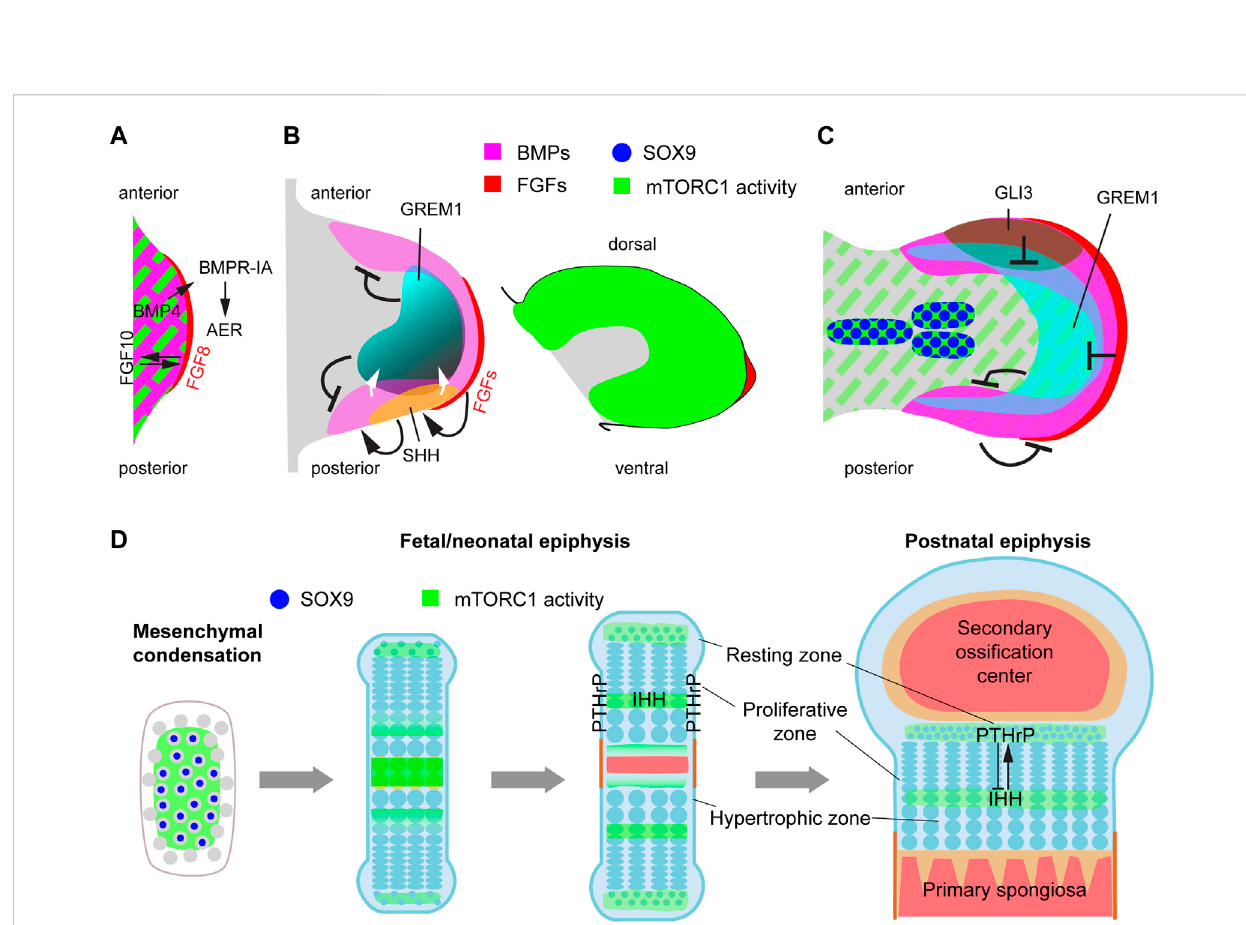
FIGURE 4 mTORC1 interacts with multiple signaling pathways and transcriptionfactors involvedin limboutgrowth, progression ofskeletal condensationsand bone growth. (A) Schematic representation of the signaling events involved in early limb-bud induction. We propose that mTORC1 could be involved in the EMT process that gives rise to the limb mesenchyme (Gros and Tabin, 2014). (B) During the patterning phase, mTORC1 activity is high in most of the limbmesenchyme,butseemstobeonlyrequiredforcellgrowthandtimelyprogressionoflimbdevelopment(Jiangetal.,2017). (C) Interactingwith BMPandHIF-1 α pathways,mTORC1isrequiredforthetransition oftheinitialcondensationstowardsproliferativecartilage (Jiangetal.,2017;Iezakietal., 2018; Lee et al., 2018). (D) Endochondral ossi fi cation process, including growth plate dynamics and main sites of mTORC1 action.